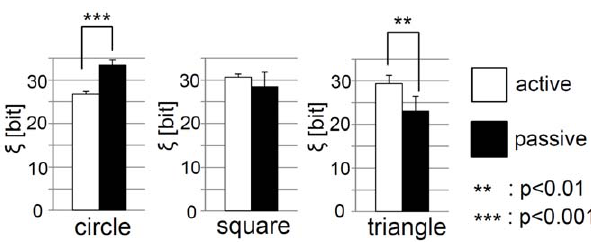
Figure 9. The averaged j of the active and passive elements for each shape. To obtain the averaged value of j , we calculated j for each trial using the last 1200 timesteps and averaged j over all the trials. The error bars show the standard deviation. Asterisks indicate significant differences, (cid:2)(cid:2) : p v 0 : 01 , (cid:2) (cid:2) (cid:2) : p v 0 : 001 . In the circular case, the averaged values of j for the active and passive elements are 26.72 + 0.64 bits and 33.42 + 1.28 bits, respectively. In the square case, the averaged values of j for the active and passive elements are 30.62 + 0.77 bits and 28.49 + 3.35 bits, respectively. In the triangular case, the averaged values of j for the active and passive elements are